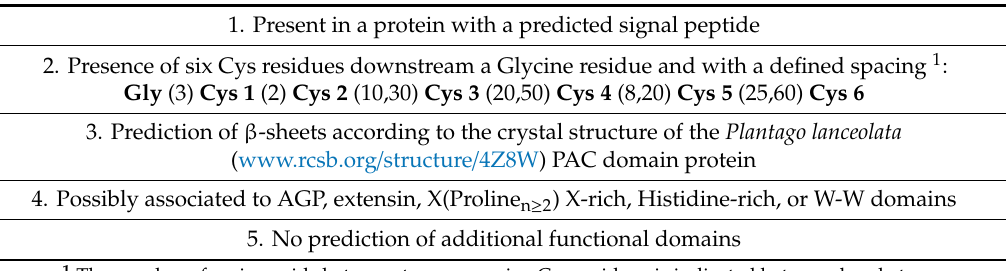
Table 1. Five features of a bona fide PAC